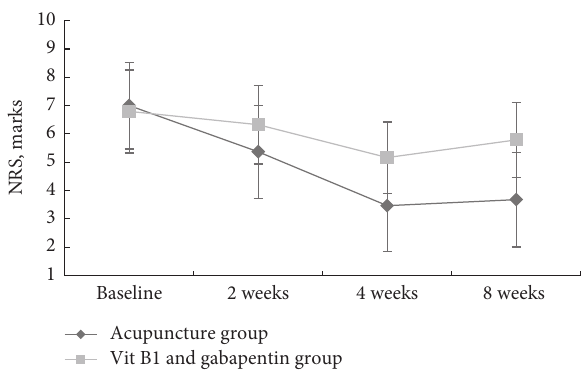
Figure 2: Comparison of NRS at baseline, after 2 and 4 weeks of treatment and 4 weeks of follow-up (8 weeks) between the 2 groups (all values are mean ±